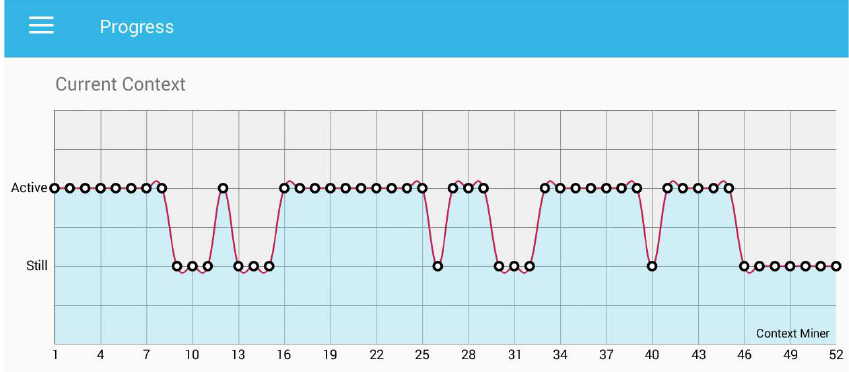
Figure 7. Current progress of the user in the last